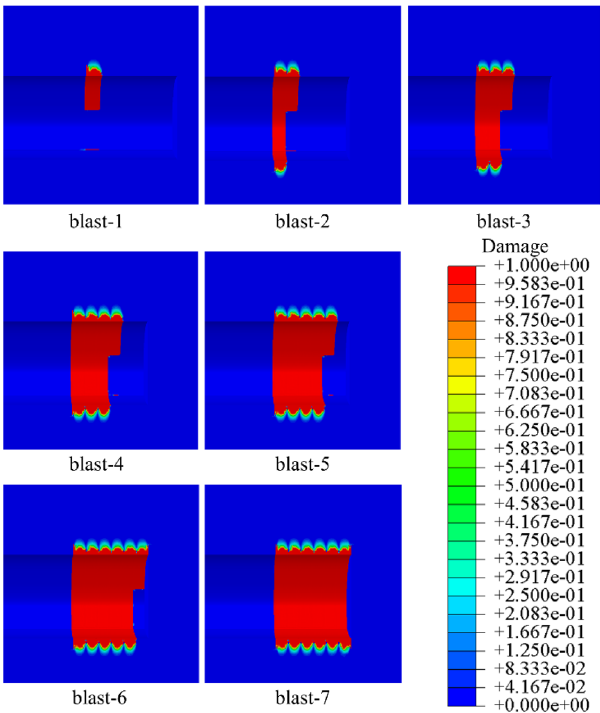
Figure 12. Damage variables of the overall reserved surrounding rock along the tunnel longitudinal.